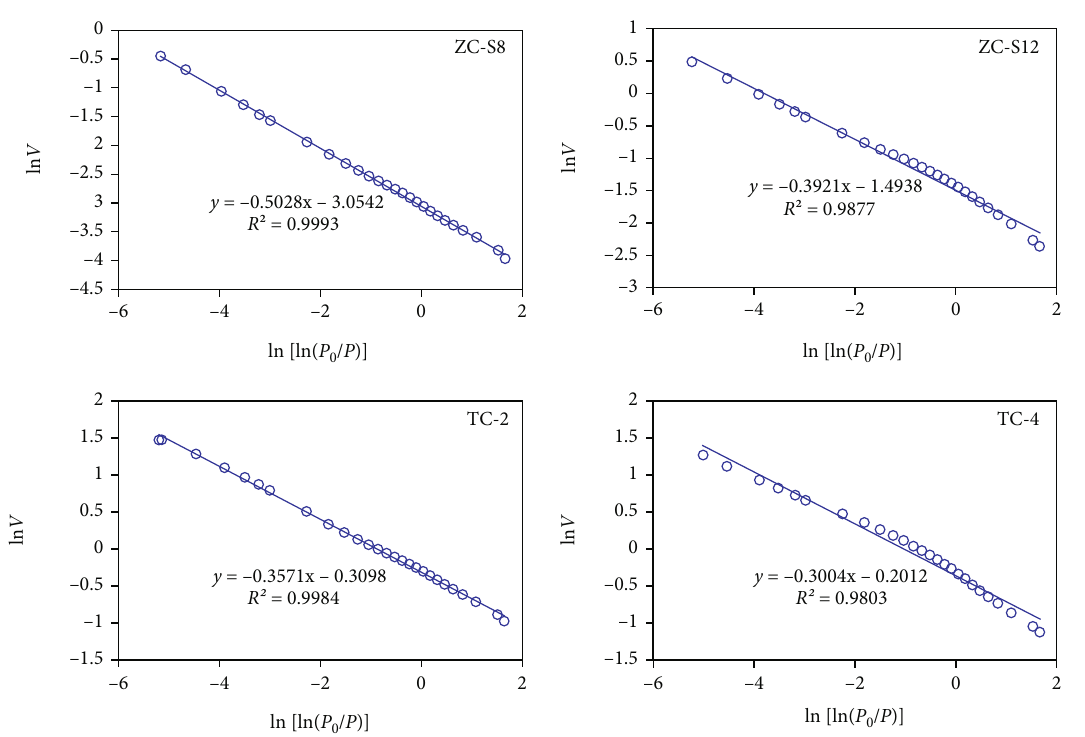
Figure 7: Plots of ln V and ln ½ ln ð P